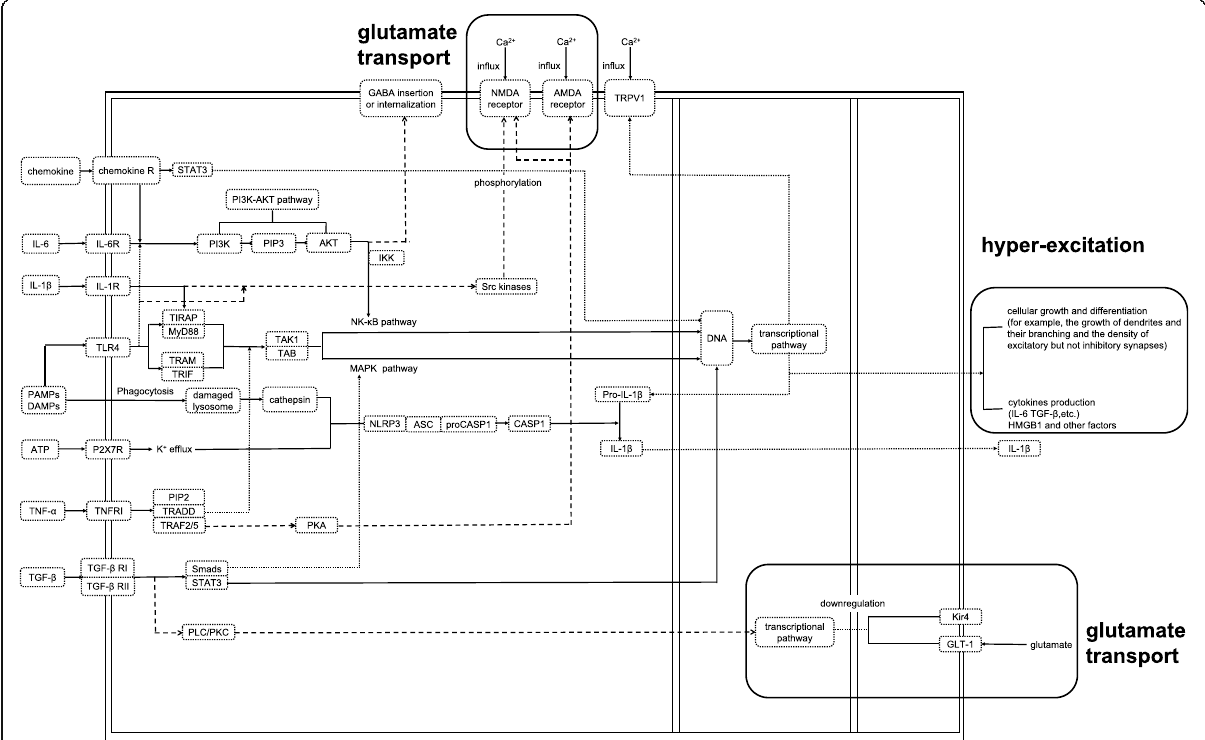
Fig. 2 Typical inflammatory mediators and their associated pathways in epileptogenesis. After an epileptogenic insult or the first seizure, both cytokines and their cognate receptors are increased. The first secretory wave of cytokines could trigger and support the second release wave of inflammatory mediators from glia or neurons, thus amplifying inflammatory downstream cascades, resulting in inflammatory caspase responses and finally neuronal hyper-excitation through transcriptional or relatively fast non-transcriptional ways. Bold dashed lines indicate unclear molecular pathways. Solid lines represent clarified pathways. STAT3: signal transducer and activator of transcription 3; IL-6: interleukin 6; IL-6R: IL-6 receptor; IL-1 β : interleukin 1 β ; IL-1R: IL-1 receptor; PIK3: phosphatidyl inositol-3 kinase; PIP3: phosphatidylinositol 3-kinase; AKT: protein kinase B; IKK: inhibitor of nuclear factor kappa-B kinase; TLR: Toll-like receptor; TIRAP: Toll-interleukin 1 receptor domain containing adaptor protein; MyD88: mediator myeloid differentiation factor 88; TRAM: Trif-related adaptor molecule; TRIF: TIR domain-containing adaptor inducing interferon- β (A kind of TIRAP); TGF- β : transforming growth factors β ; TAK1: TGF- β activated kinase 1; TAB: TAK1 binding protein; NK- κ B: nuclear factor kappa-B; MAPK: mitogen-activated protein kinases; PAMPs: pathogen-associated molecular patterns; DAMPs: damage-associated molecular patterns; ATP: adenosine triphosphate; P2X7Rs: purinergic ligand-gated ion channel 7 receptors; TNF- α : tumor necrosis factor α ; TNFR1: tumor necrosis factor receptor 1; PIP2: phosphatidylinositol (4,5) bisphosphate; TRADD: TNF receptor 1 associated death domain; TRAF: TNF receptor-associated factor; PKA: protein kinase A; Smad: Contraction of Sma and Mad; PKC: protein kinase C; PLC: phospholipase C; NLRP3: NOD-like receptor protein 3; CASP1: caspase 1; GABA: γ -aminobutyric acid; NMDA: N-methyl-D-aspartic acid; AMPA: α -amino-3-hydroxy-5-methyl-4-isoxazole-propionicacid; TRPV1: transient receptor potential vanilloid 1; GLT: glutamate transporter 1; HMGB1: high mobility group box